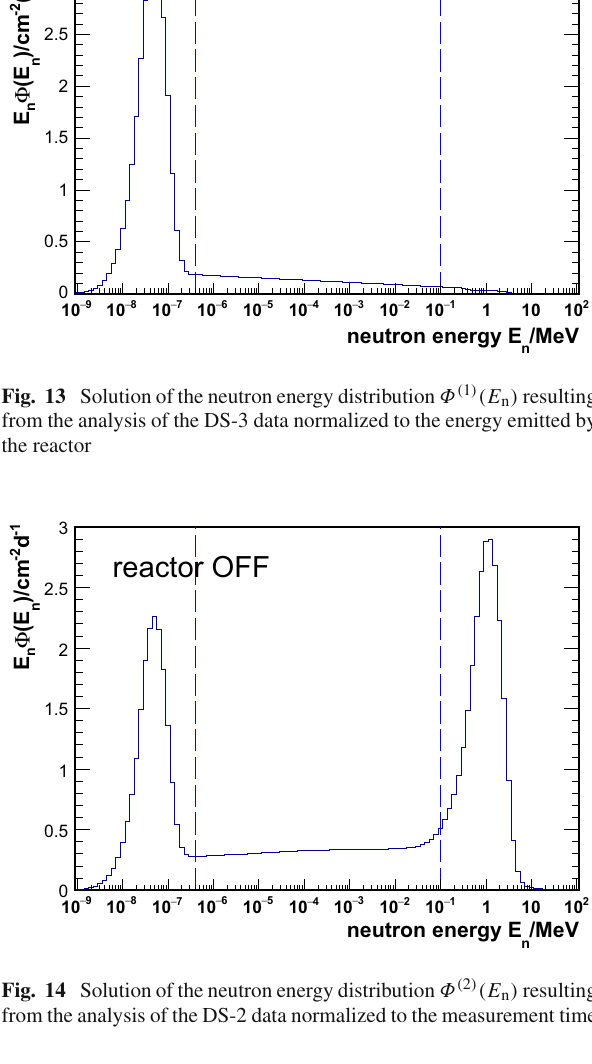
Table 6 Neutron fluence Φ ( 1 ) derived from the analysis of the DS- 3 measurement, and normalized to the KBR thermal energy out- put of 1GWh. The uncertainties are stated as standard